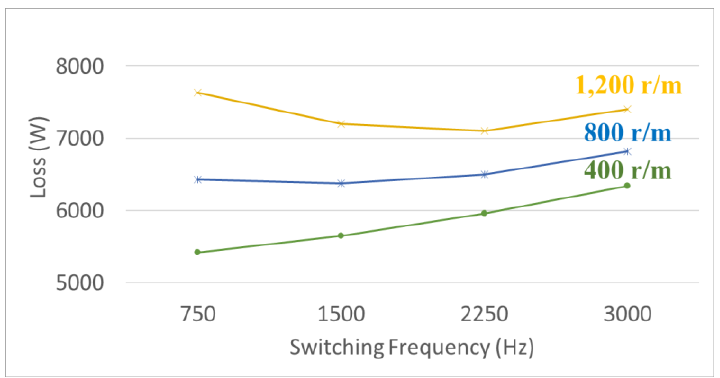
Figure 16. The total power loss of the propulsion system depending on speed (r/m).